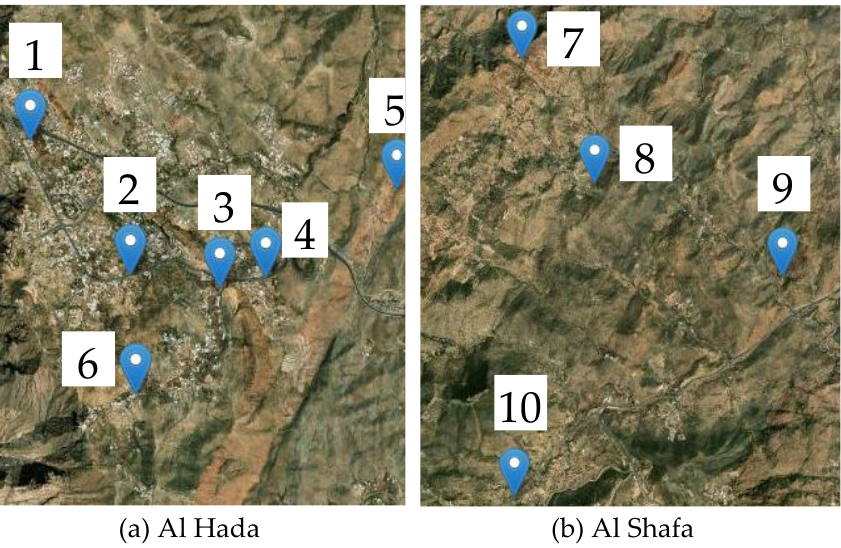
Figure 2. Geographical locations of the 10 Taif roses farms (Al Hada ( a ) and Al Shafa ( b )), from which samples are collected.